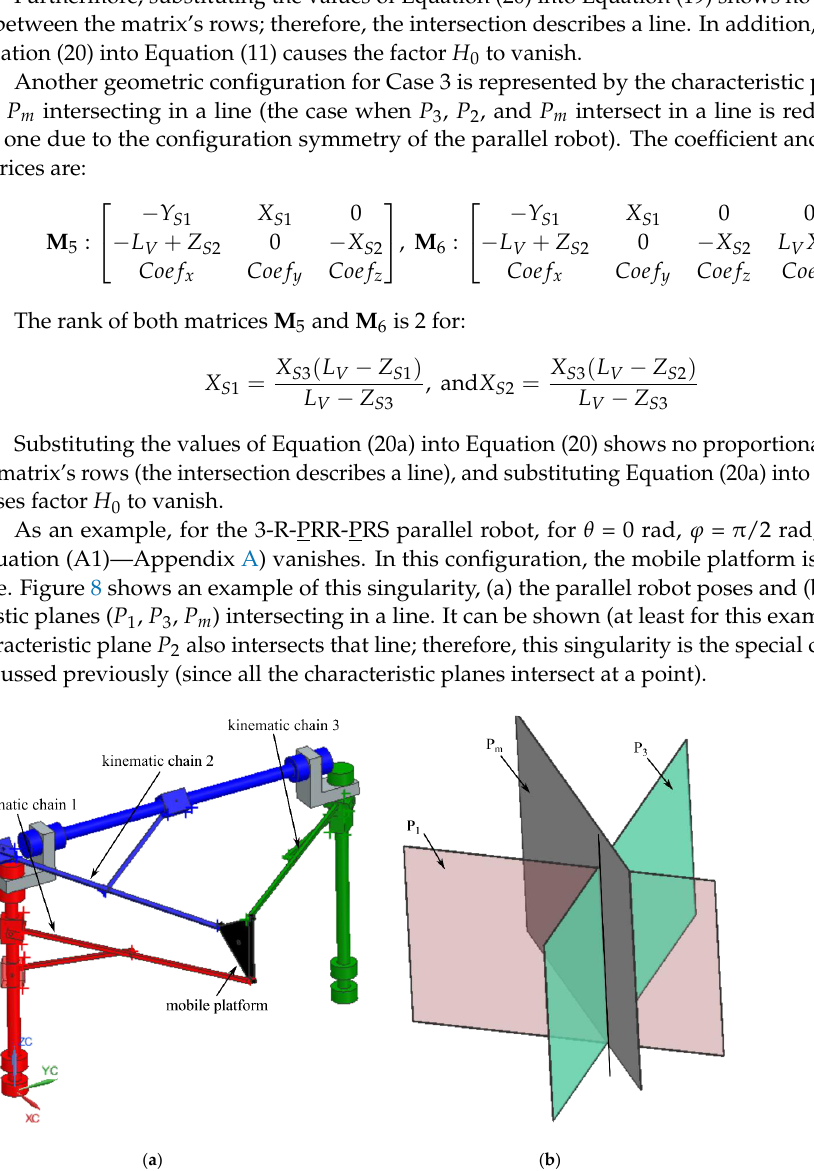
Figure 8. Type II singularity of the 6-DOF parallel robot for SILS (case 3—two faces of the characteristic tetrahedron and its base intersect in a line): ( a ) parallel robot pose; ( b ) characteristic planes intersect in a